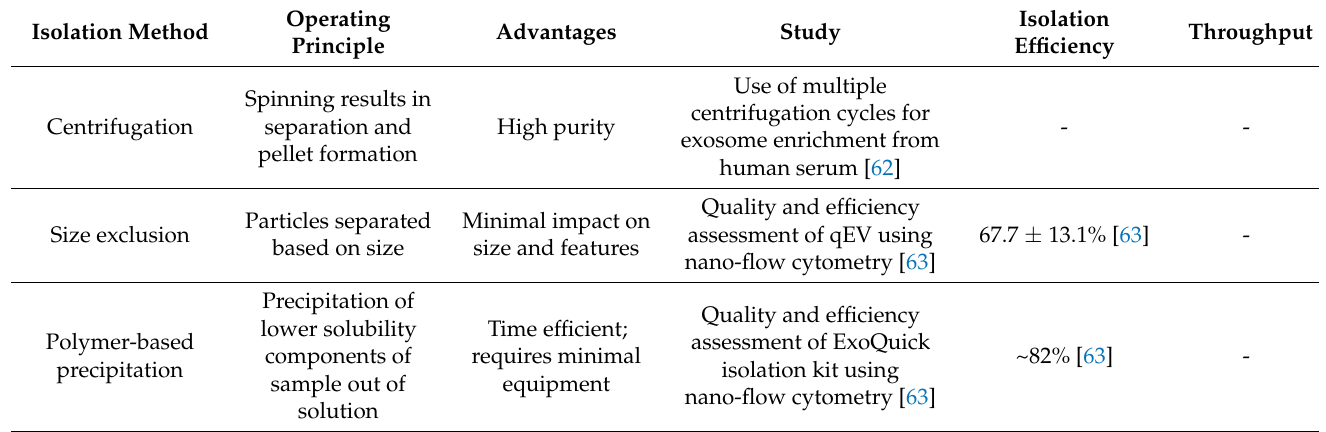
Table 1. Table summarizing conventional isolation techniques for